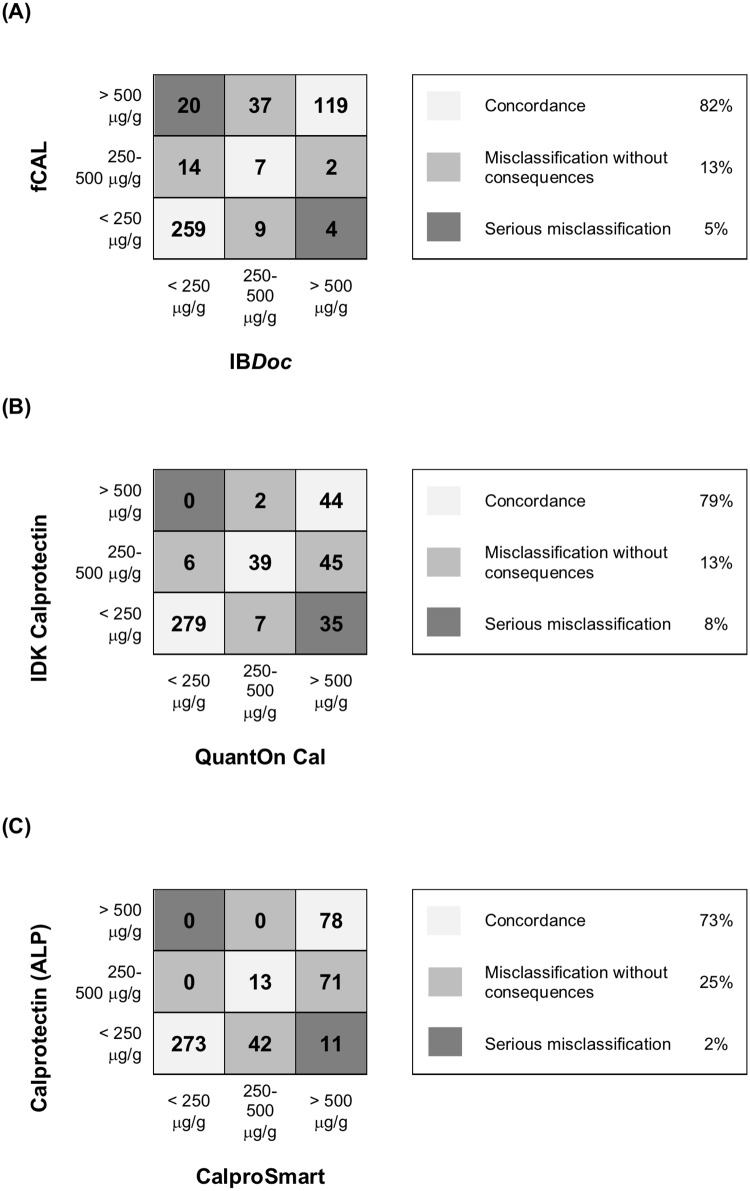
Simplified concordance matrices showing calprotectin readings with (A) IBDoc against fCAL; (B) QuantOn Cal against IDK Calprotectin; and (C) CalproSmart against Calprotectin (ALP).